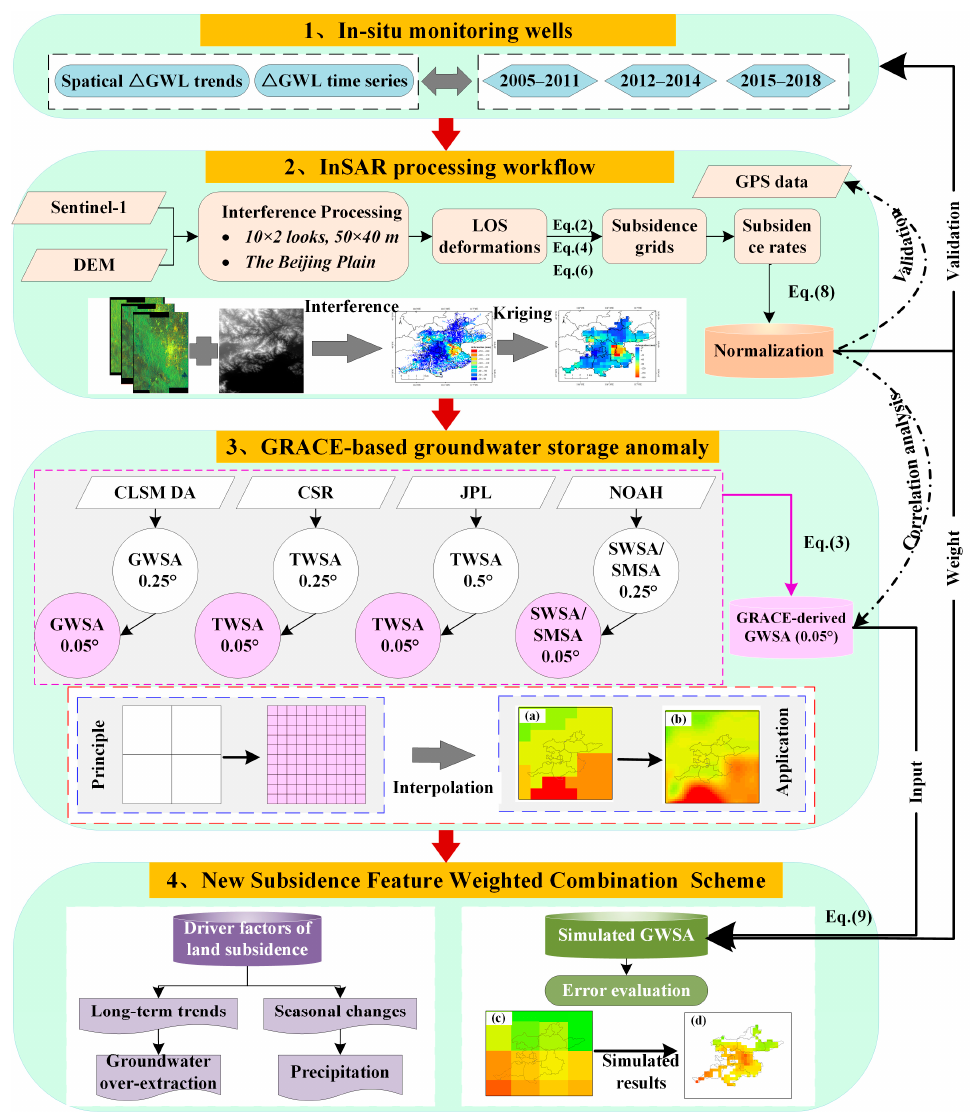
Figure 2. The flowchart of data processing. ( a ) 0.25° CSR-GWSA; ( b ) 0.05° CSR-GWSA; ( c ) 0.5° CSR-GWSA; ( d ) 0.05° simulated CSR-GWSA.